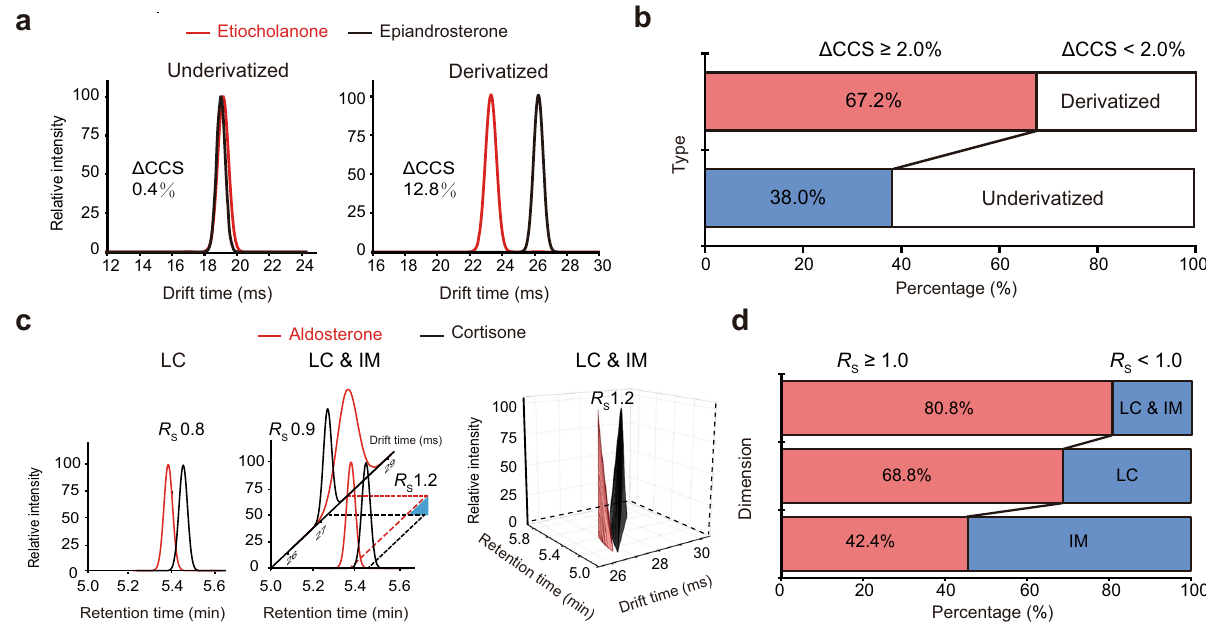
Fig. 2 Improved separation of sterol isomers with derivatization and IM-MS. a Overlay of the IM mobiligrams of underivatized and derivatized sterol isomers of etiocholanone and epiandrosterone. b The percentages of sterol isomers with signi fi cant CCS differences ( ≥ 2%) in the derivatized ( n = 125) and underivatized ( n = 163) groups. c The peak resolutions ( R S ) in LC separation (left), IM separation and LC-IM based two-dimensional separation (middle and right) for the sterol isomers of aldosterone and cortisone after derivatization. d The percentages of sterol isomers ( n = 125) with peak resolutions larger than 1.0 in LC separation, IM separation, and LC-IM based two-dimensional